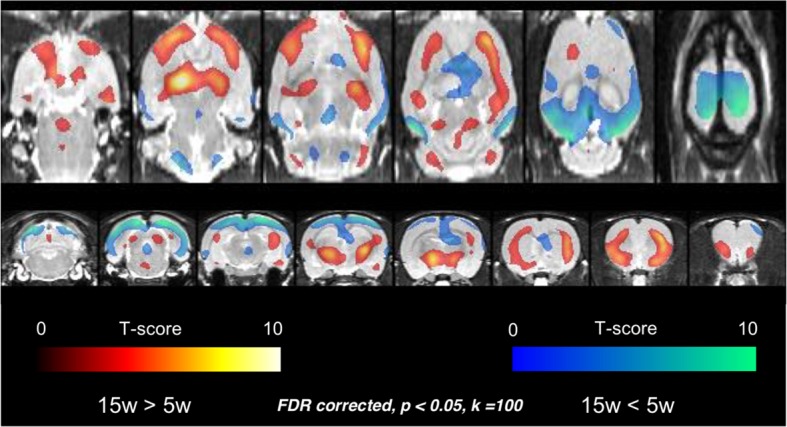
Voxelwise comparison between 5-week-old and 15-week-old rats.The patterns of increase and decrease of metabolism were similar to the comparison between 5-week and 10-week-old rats. The findings imply that metabolic maturation in the brain occurs before 10 weeks and almost reaches plateau.